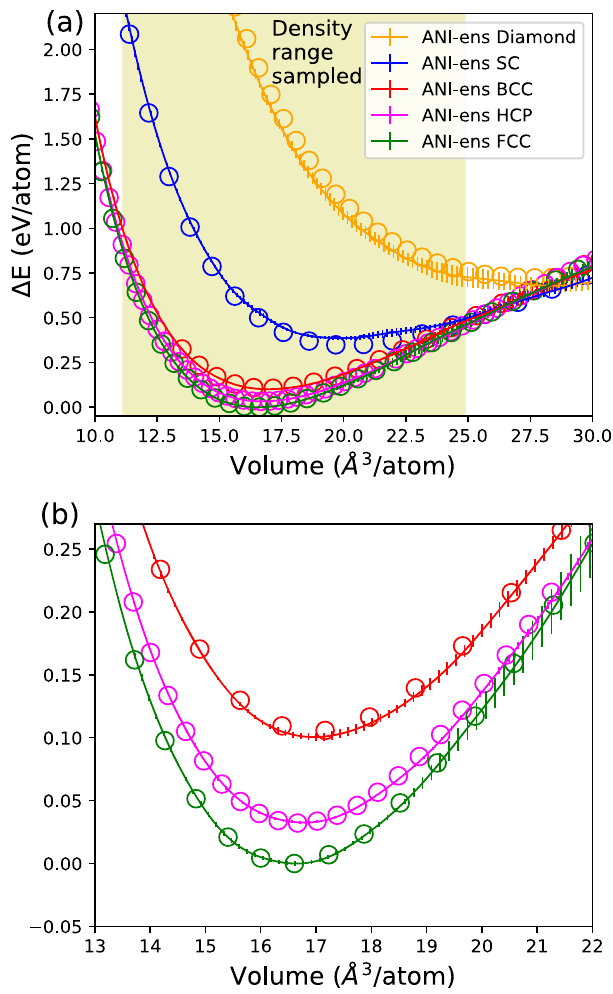
Fig. 1 Crystal energies relative to the ground state. Solid lines represent ANI-Al predictions and circles represent density functional theory (DFT) reference calculations. Vertical bars represent sample variance of the eight neural networks comprising the (ensembled) ANI-Al model. Panel ( b ) is a magni fi cation of panel ( a ) near the energy minima. The highlighted yellow region (~11 – 25 Å 3 /atom) indicates the approximate range of densities sampled in the training data. Crystal structures are diamond, simple cubic (SC), body-centered cubic (BCC), hexagonal close-packed (HCP), and face- centered cubic